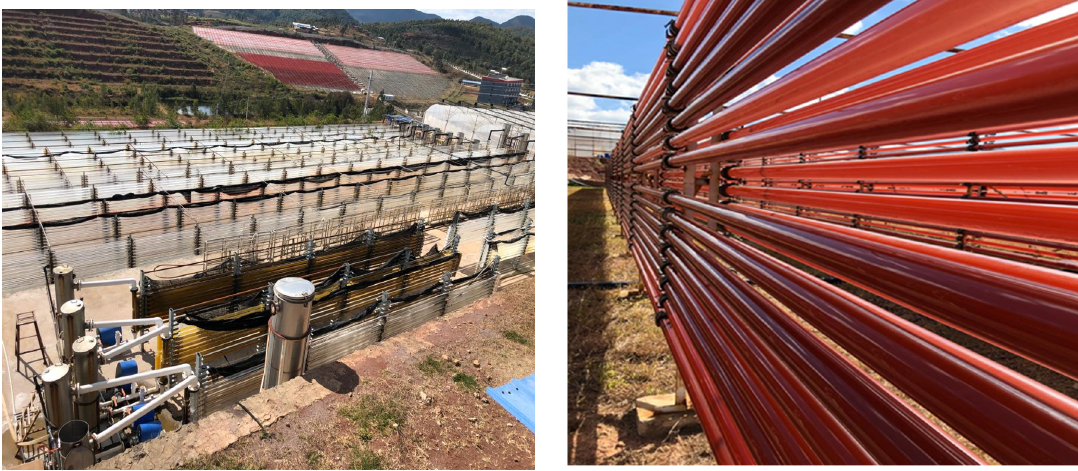
Figure 4. Closed tube bioreactor algae production facility in Yunnan Province, China (Courtesy: Nicholas Cheong, Nova Laboratories Sdn. Bhd.).